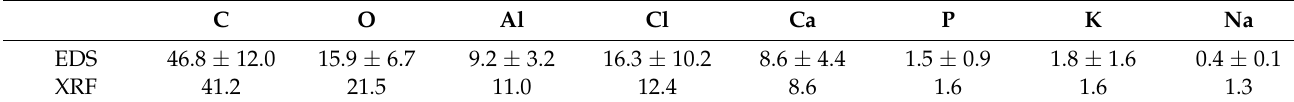
Table 3. Elemental composition (weight%) of Al-FWB analyzed using an energy dispersive spectrom- eter (EDS) and an X-ray fluorescence (XRF) spectrometer.